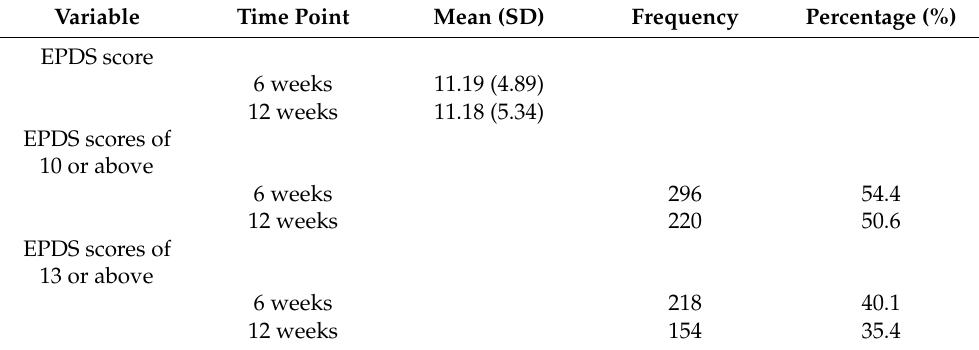
Table 5. The mean EPDS scores and the proportions with EPDS scores of 10 or above and 13 or above at 6 ( n = 544) and 12 weeks ( n = 435) postpartum.